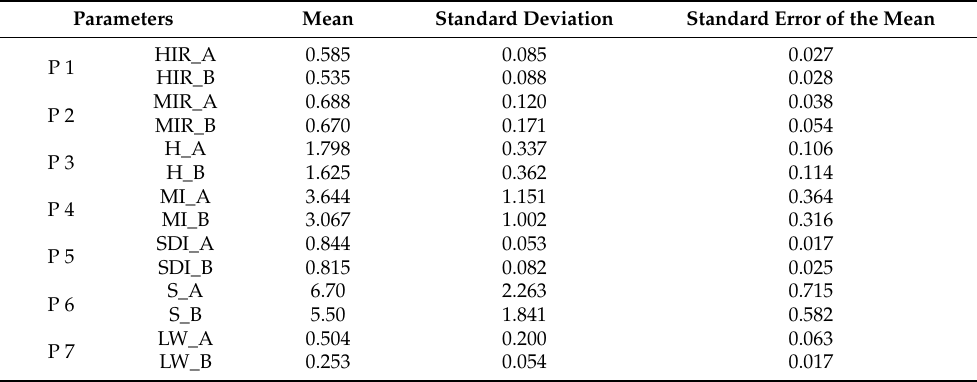
Table 2. Basic descriptive statistics for dependent